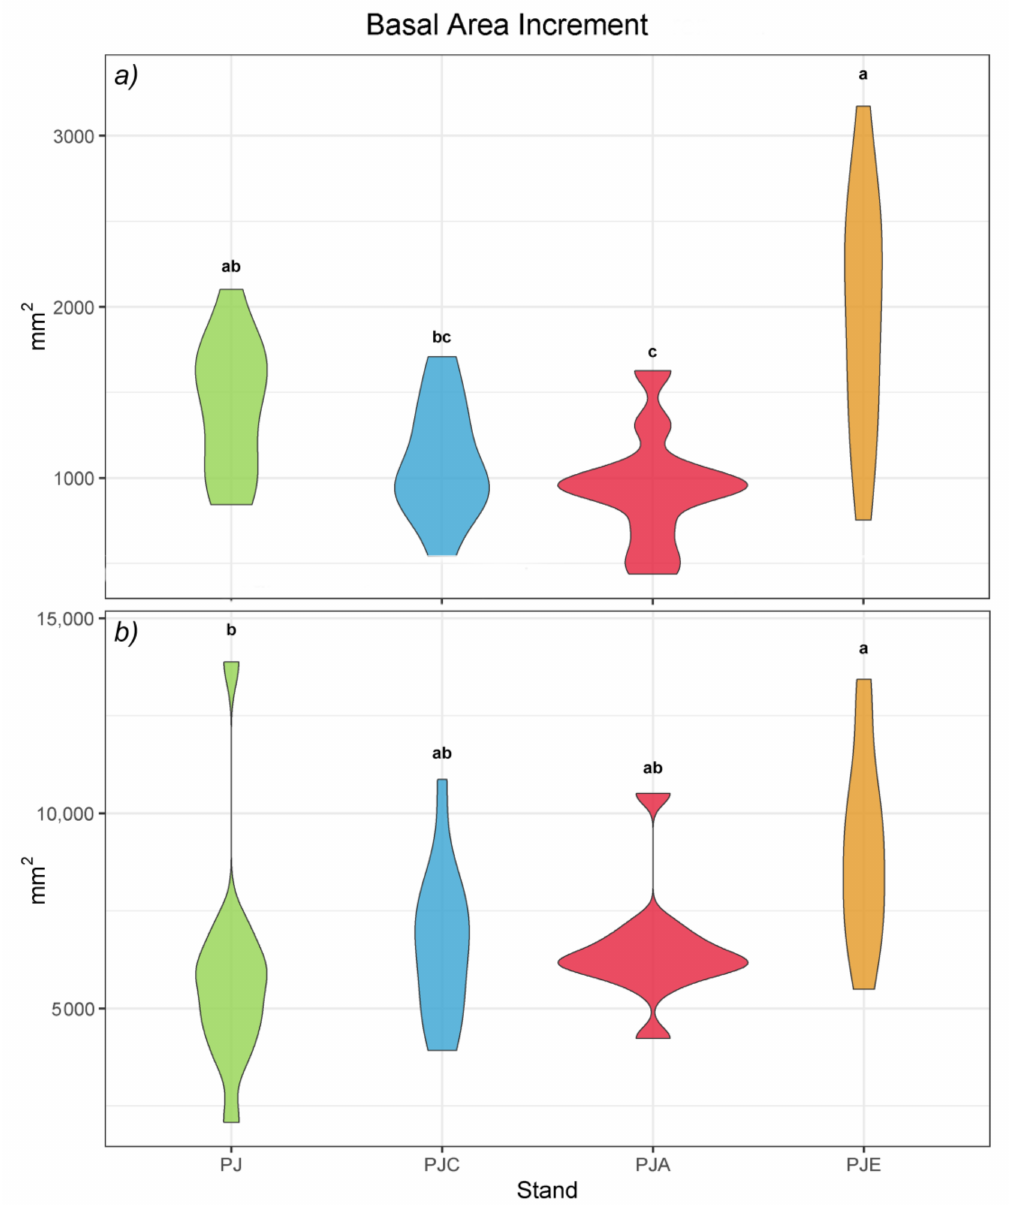
Figure 5. Violin plot of the basal area increment (BAI) of ( a ) Juglans regia and ( b ) Populus alba trees expressed in mm 2 . Different letters indicate significant differences ( p ≤ 0.05, Tukey’s post-hoc test following one-way ANOVA). See Table 1 for site